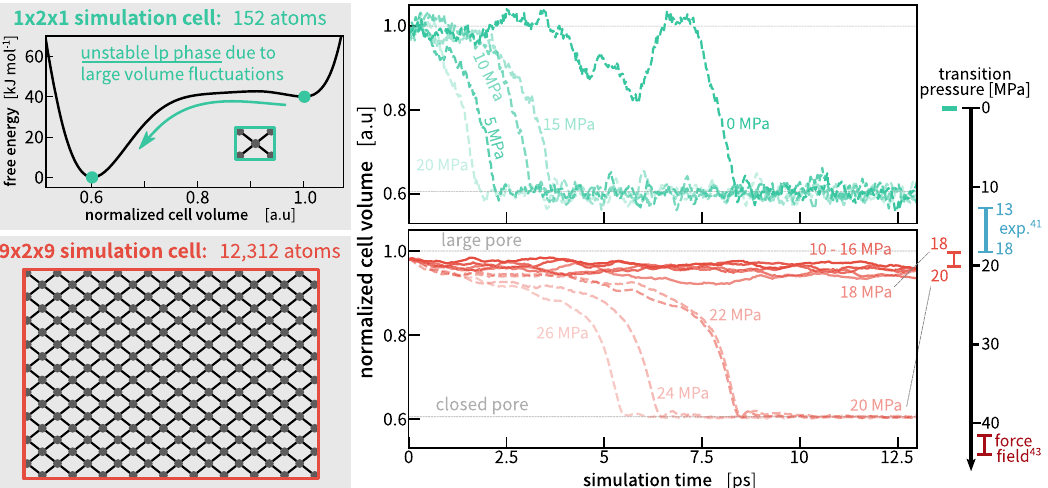
Fig. 5 Estimating the transition pressure via large-scale dynamics. We compare estimates using a regular 1 × 2 × 1 unit cell versus a large- scale 9 × 2 × 9 unit cell, as obtained based on ( N , P , T ) dynamics. All unit cell volumes were normalized with respect to the lp minimum of the Helmholtz free energy surface at 300 K, which occurs at 2882 Å . Nevertheless, the lp phase is not stable for the 1 × 2 × 1 cell due to the larger volume fl uctuations. In contrast, the 9 × 2 × 9 cell allows to determine a transition pressure in the range of 18--20 MPa, which is in good agreement with experiment 41